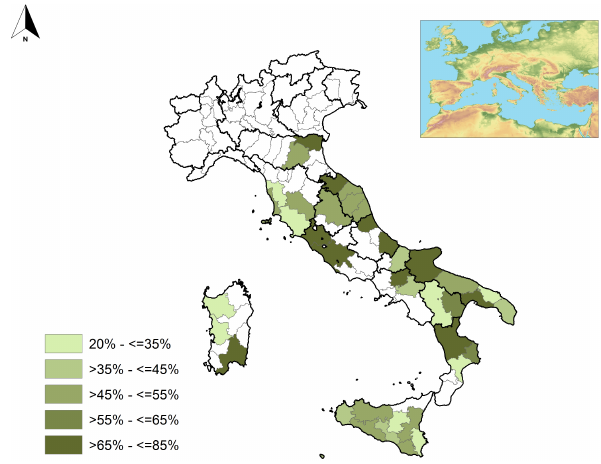
Figure 6. Number of concurrent early heat waves and significant negative yield anomalies in the period 1995–2013 (expressed in per- centage with respect to the total number of year with significant negative yield